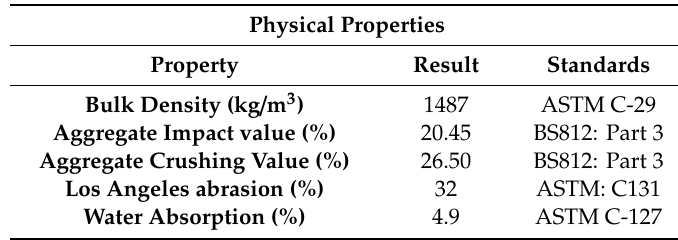
Table 4. Physical properties of coarse aggregate.